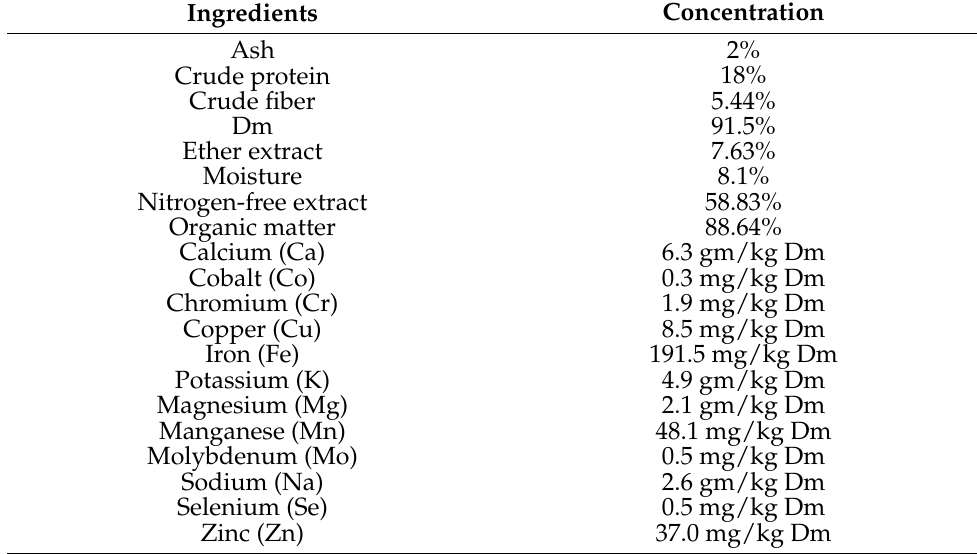
Table 2. Chemical composition of alfalfa hay cubes.